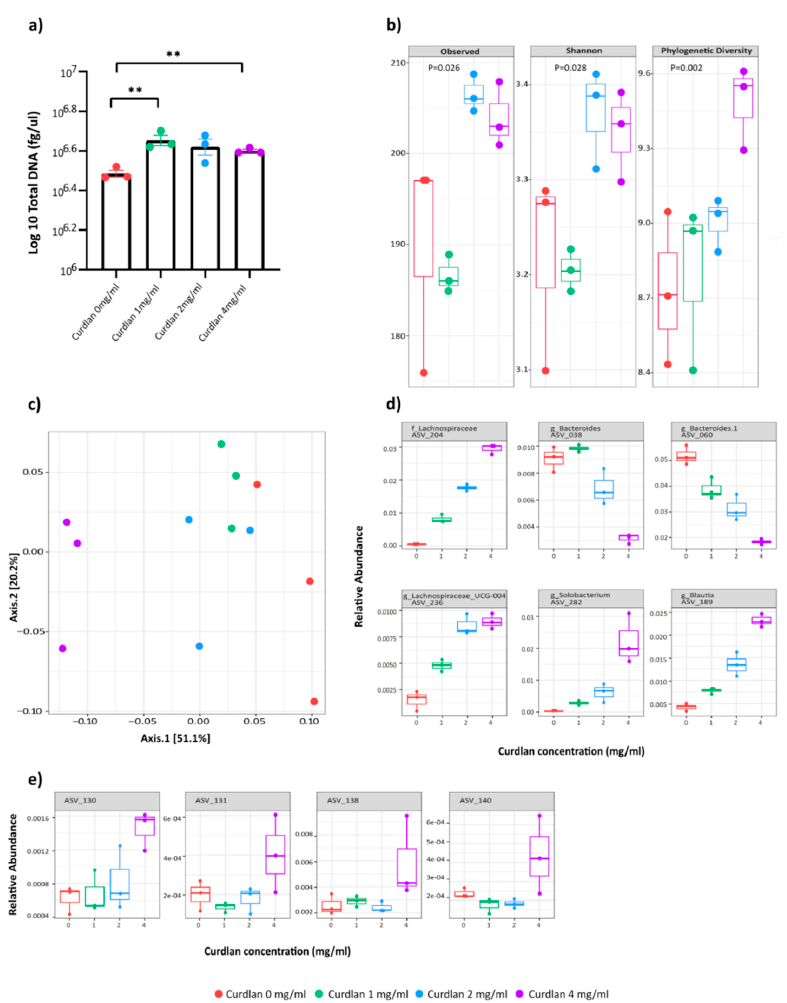
Figure 5. Effect of curdlan on human microbiota using in vitro i-screen. ( a ) Total DNA load of bacterial 16S as measured through qPCR. Statistical differences were tested by independent t-tests, where a p -value of < 0.05 was considered to be significant. ** p -value < 0.01. ( b ) For 16S sequencing, alpha diversity is measured by observed, Shannon and phylogenetic diversity metrics, and significance is tested using Kruskal–Wallis. ( c ) Effect of curdlan concentration on beta diversity (principal coordinate analysis (PCoA) Bray–Curtis dissimilarity)). ( d ) Boxplots for the top 6 most significant lineages (family and genus) that show linear relation with different curdlan concentrations. ( e ) Boxplots for 4 Bifidobacterium lineages with different curdlan concentrations.